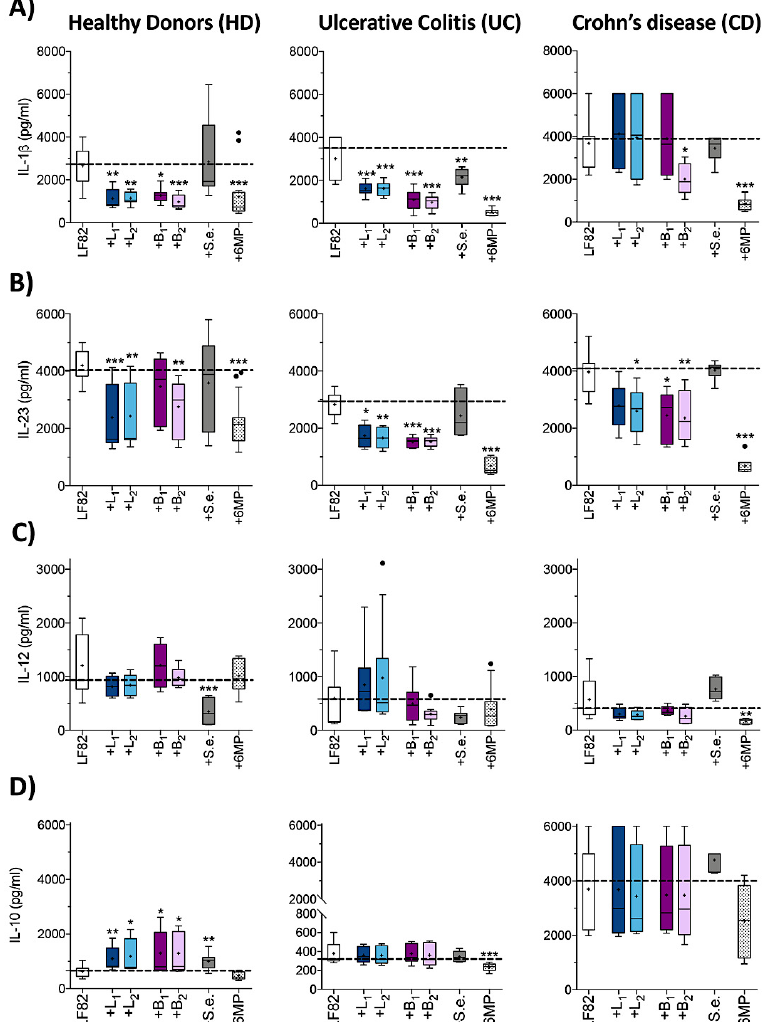
Figure 5. Effects of probiotic strains on cytokine secretion by MoDC derived from HD, UC and CD patients infected with AIEC-LF82 strain. Secretion of IL-1 β ( A ), IL-23 ( B ), IL-12 ( C ) and IL-10 ( D ) in the supernatants of MoDC derived from HD, UC patients or CD patients after 24 h of infection with AIEC-LF82 alone or in the presence of either Lactobacillus strains ( + L 1 or + L 2 ) or Bifidobacterium strains ( + B 1 or + B 2 ) or S. epidermidis ATCC-155 ( + S.e.), at 1:1 ratio or in the presence of 6MP (2 µ g / mL), was quantified by ELISA. Dot lines (—) represent the median values for cytokine secretion of MoDC infected with LF82 alone. Data are represented as described in Figure 1. Statistical significance for each condition compared to MoDC infected with LF82 alone was reported (* p < 0.05, ** p < 0.01, *** p < 0.001).